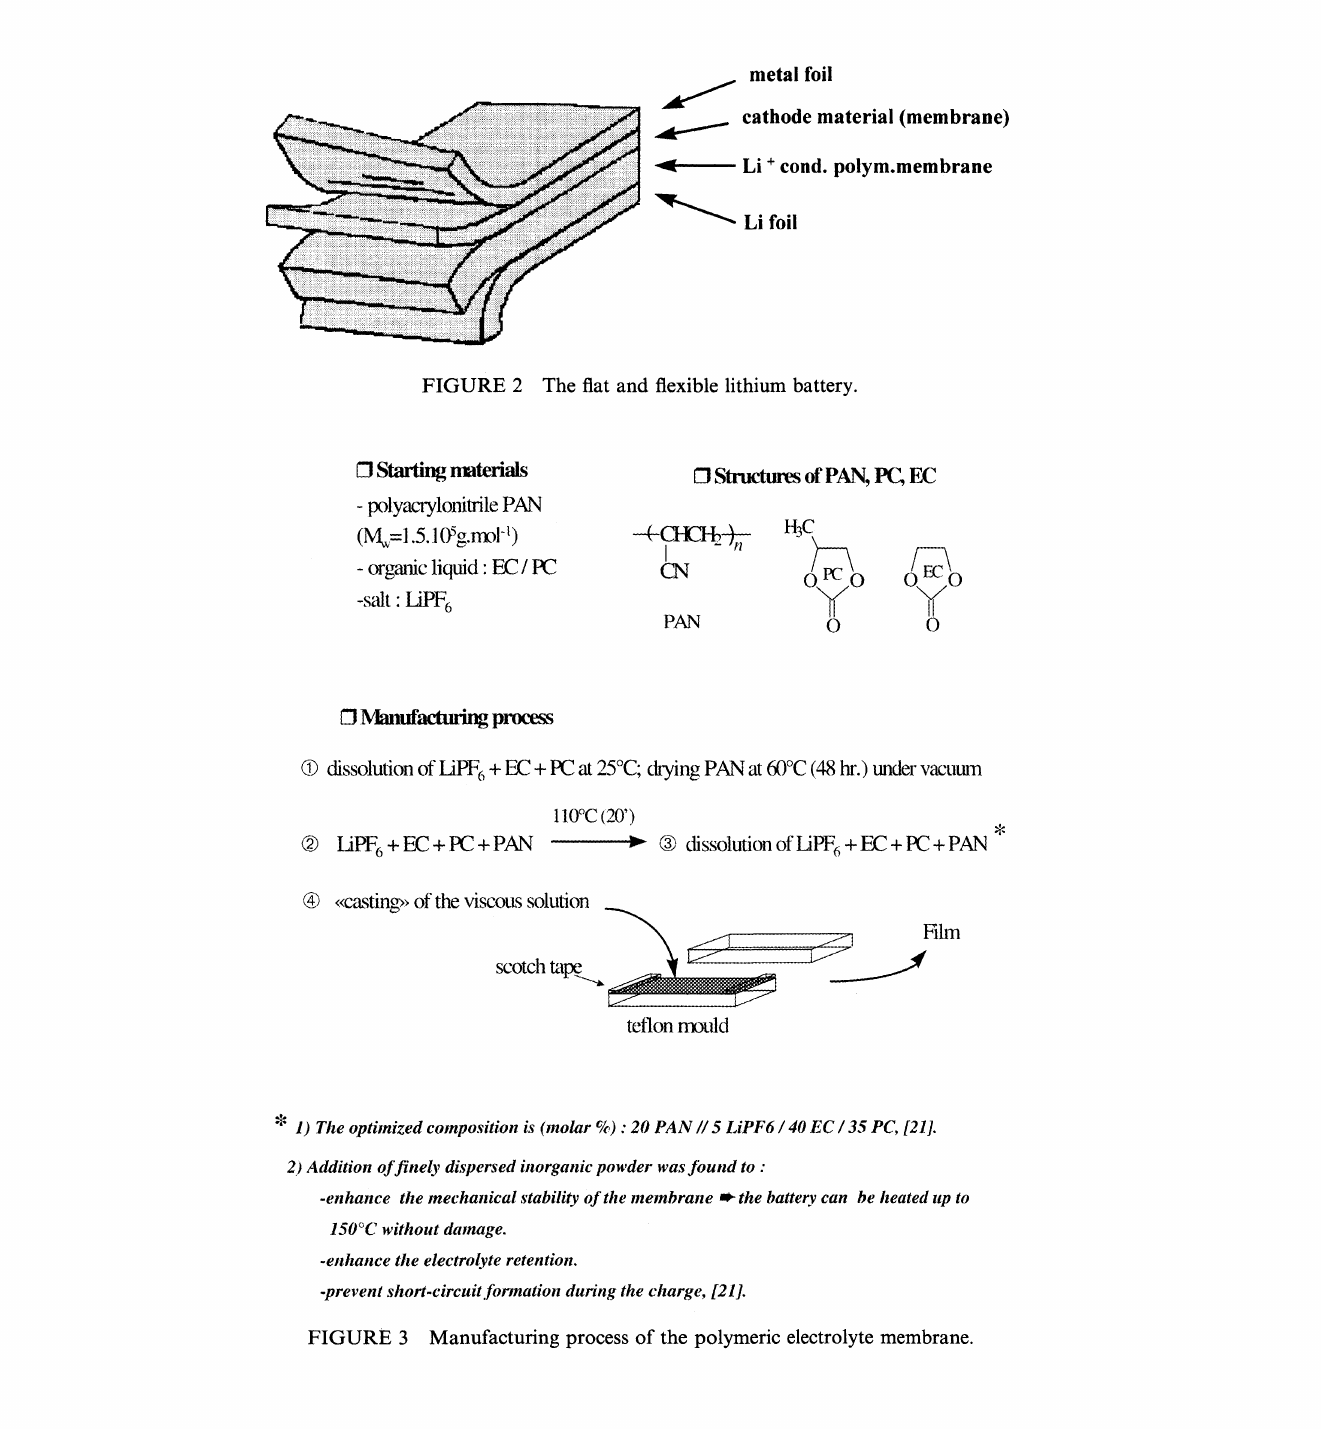
FIGURE 3 Manufacturing process of the polymeric electrolyte